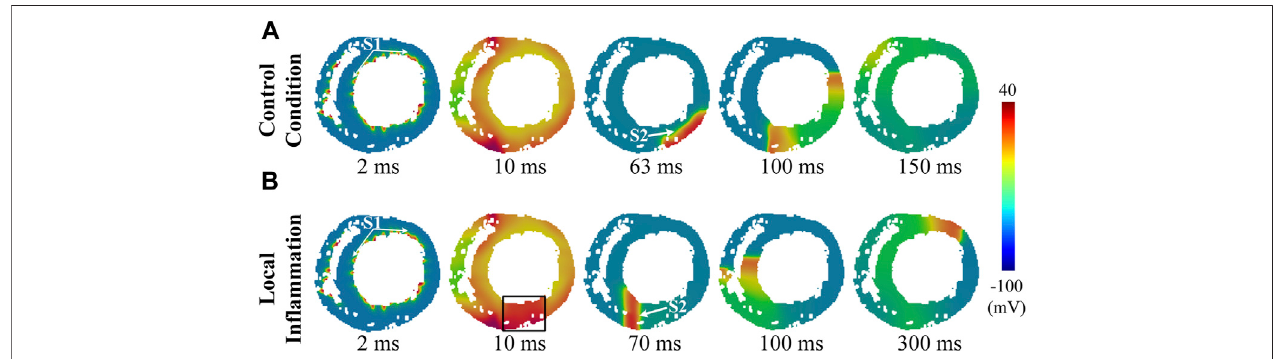
FIGURE 5 | Induced reentry arrhythmias in rat ventricular slices under conditions of (A) control and (B) local in fl ammation. The S1 and S2 stimuli are marked by white arrows, while the in fl ammatory region is indicated by a black rectangle.